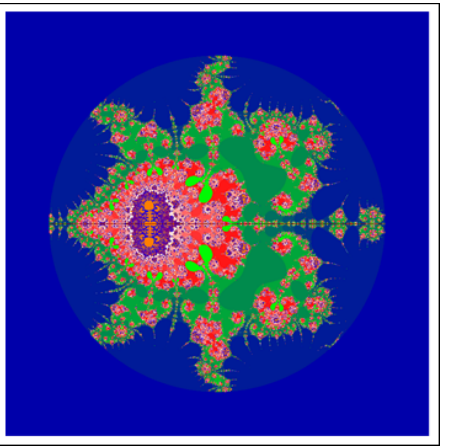
Figure 17. J-set via F-iteration for sin ( z 4 ) + 0.55 with image visual time = 91.7